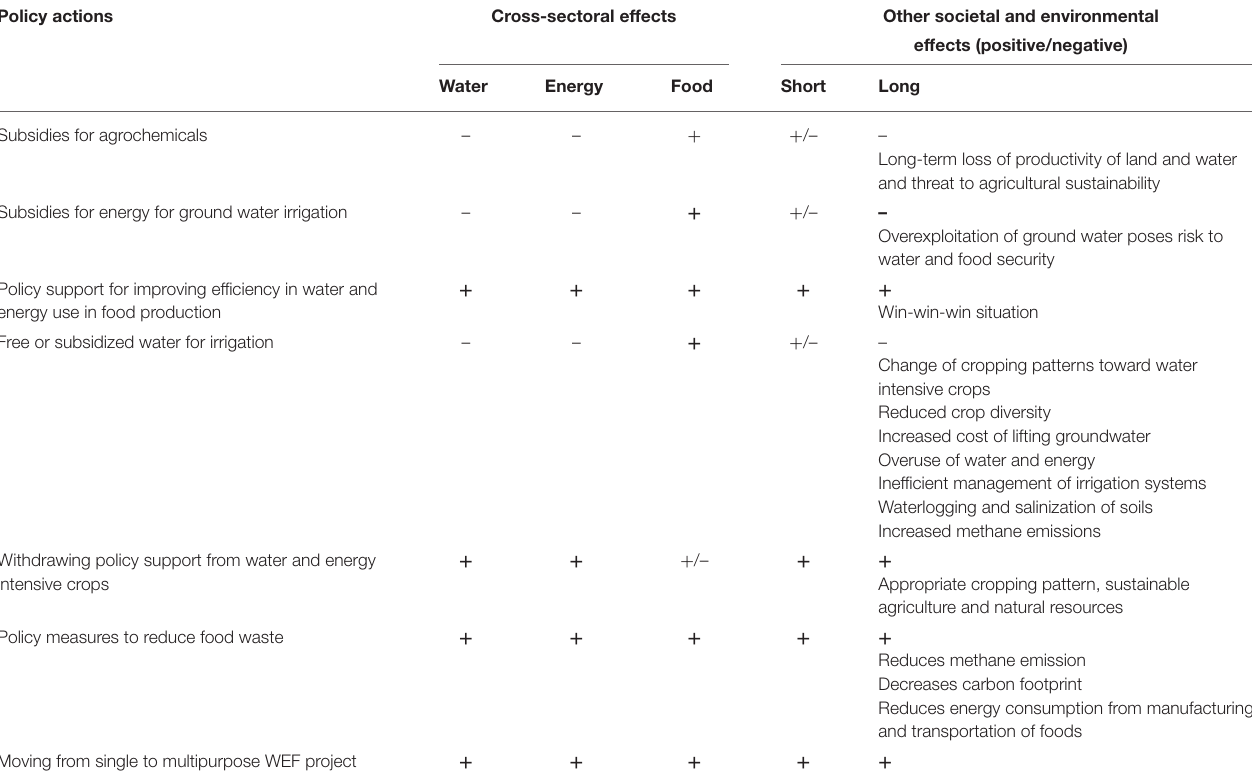
TABLE 3 | Illustrative example of a qualitative assessment of nexus interactions of different policy options and